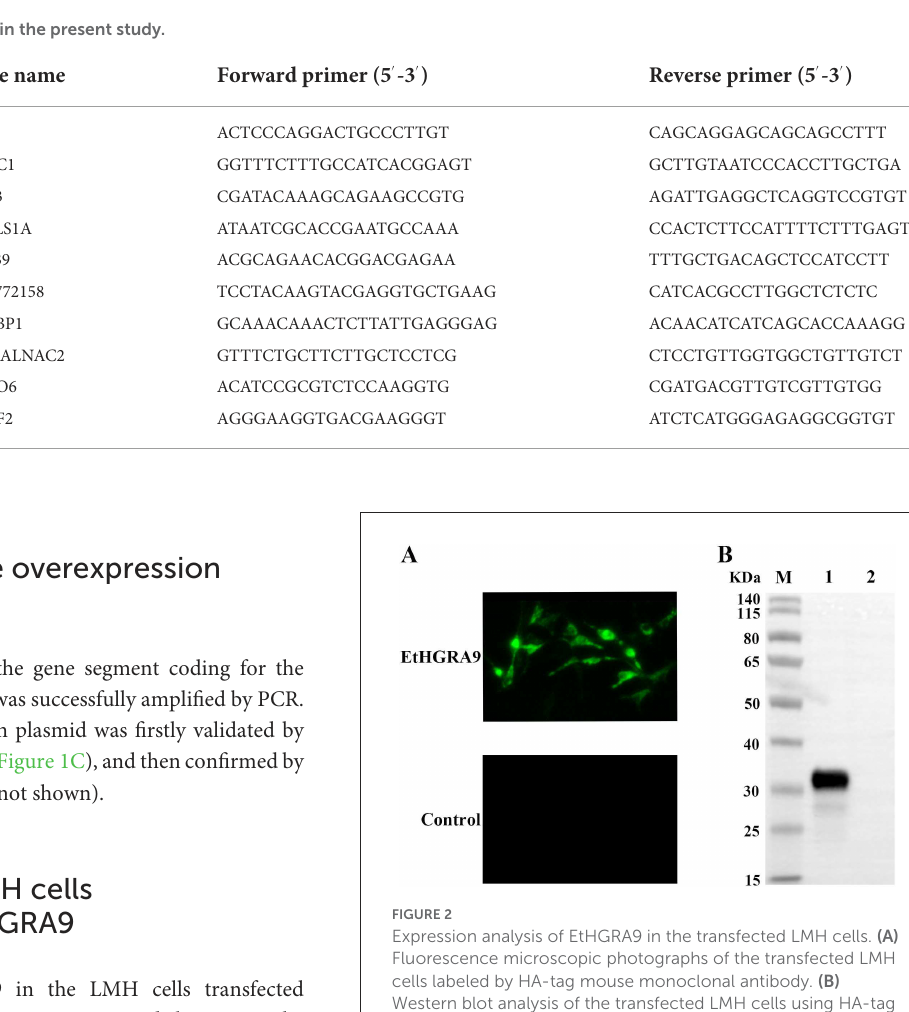
cells overexpressing EtHGRA9. Of which, 275